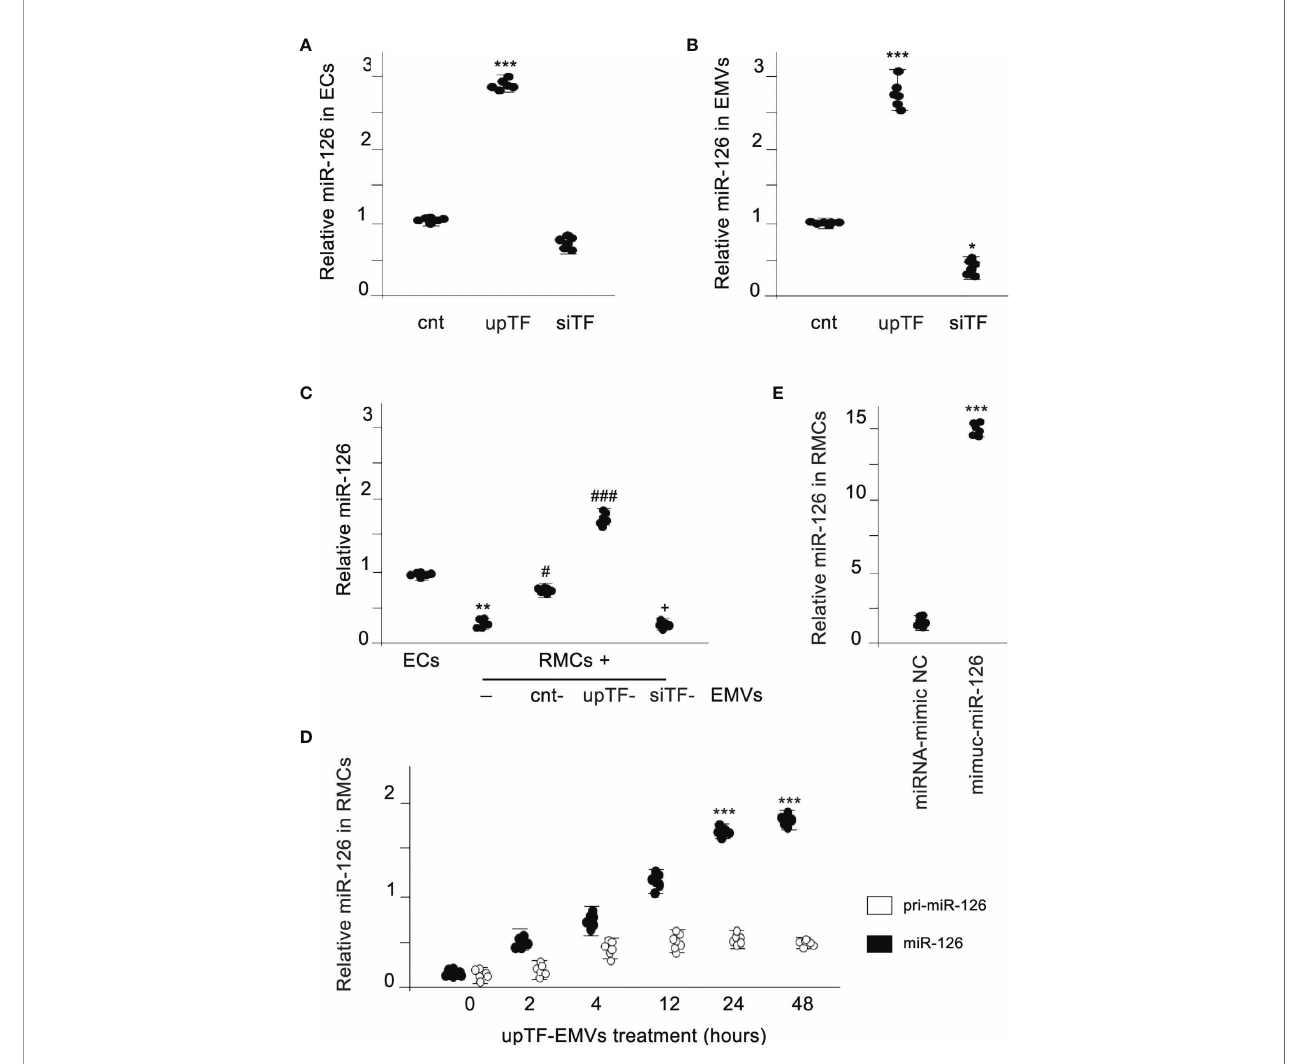
FIGURE 1 | MiR-126 is transferred from EMVs to monocytic cells. (A) Expression of TF in ECs results in a dependent expression of miR-126 in ECs. MiR-126 expression levels were analyzed in ECs transfected with control vector (cnt), TF overexpression vector (upTF), or silencing TF (siTF) by qRT-PCR. Values are expressed as mean ± SEM. Statistical analysis was performed by ANOVA followed by Tukey ’ s post-hoc test. *** p < 0.001 vs. cnt ( N = 6). (B) qRT-PCR was used to assess the expression of miR-126 in EMVs released from activated control ECs, TF overexpressing ECs (upTF), or TF-silenced ECs (siTF). Values are expressed as mean ± SEM. Statistical analysis was performed by ANOVA followed by Tukey ’ s post-hoc test. * p < 0.05 and *** p < 0.001 vs. cnt ( N = 6). (C) MiR-126 expression analyzed by qRT-PCR in endothelial cells (EC) and RMCs treated for 24 h without or with EMVs released from control ECs, TF overexpressing ECs (upTF) or TF silenced ECs (siTF). Values are expressed as mean ± SEM. Statistical analysis was performed by ANOVA followed by Tukey ’ s post-hoc test. ** p < 0.01 vs. ECs, # p < 0.05, and ### p < 0.001 vs. RMCs without EMVs and + p < 0.05 vs. RMCs treated with cnt-EMVs ( N = 6). (D) Kinetics of mature miR-126 and pri-miR-126 expression after treatment of RMCs with upTF-EMVs. Statistical analysis was performed by ANOVA followed by Tukey ’ s post-hoc test. *** p < 0.001 vs. time 0. ( N = 6). (E) Expression of miR-126 in RMCs treated with EMVs released from ECs transfected with miRNA-mimic-negative control (NC) or mimic-miR-126. Values are expressed as mean ± SEM. Statistical analysis was performed by ANOVA followed by Tukey ’ s post-hoc test. *** p < 0.001 vs. cnt ( N =